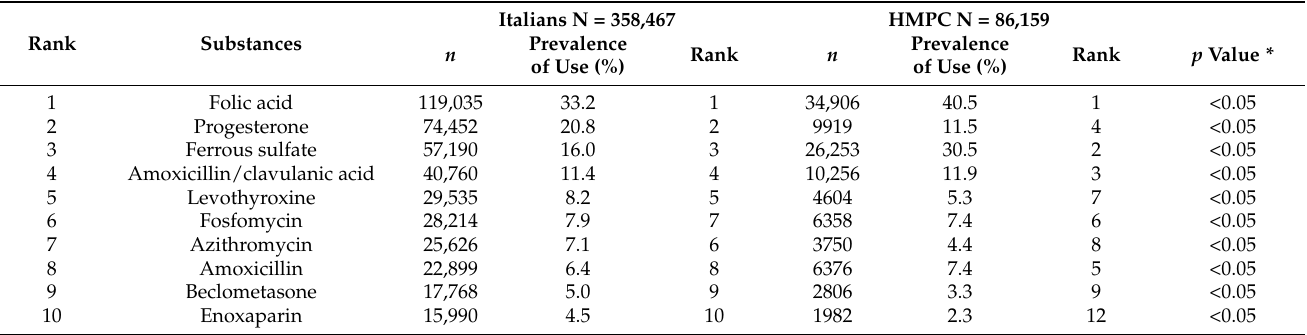
Table 2. Ranking of the most 10 prescribed substances during pregnancy by